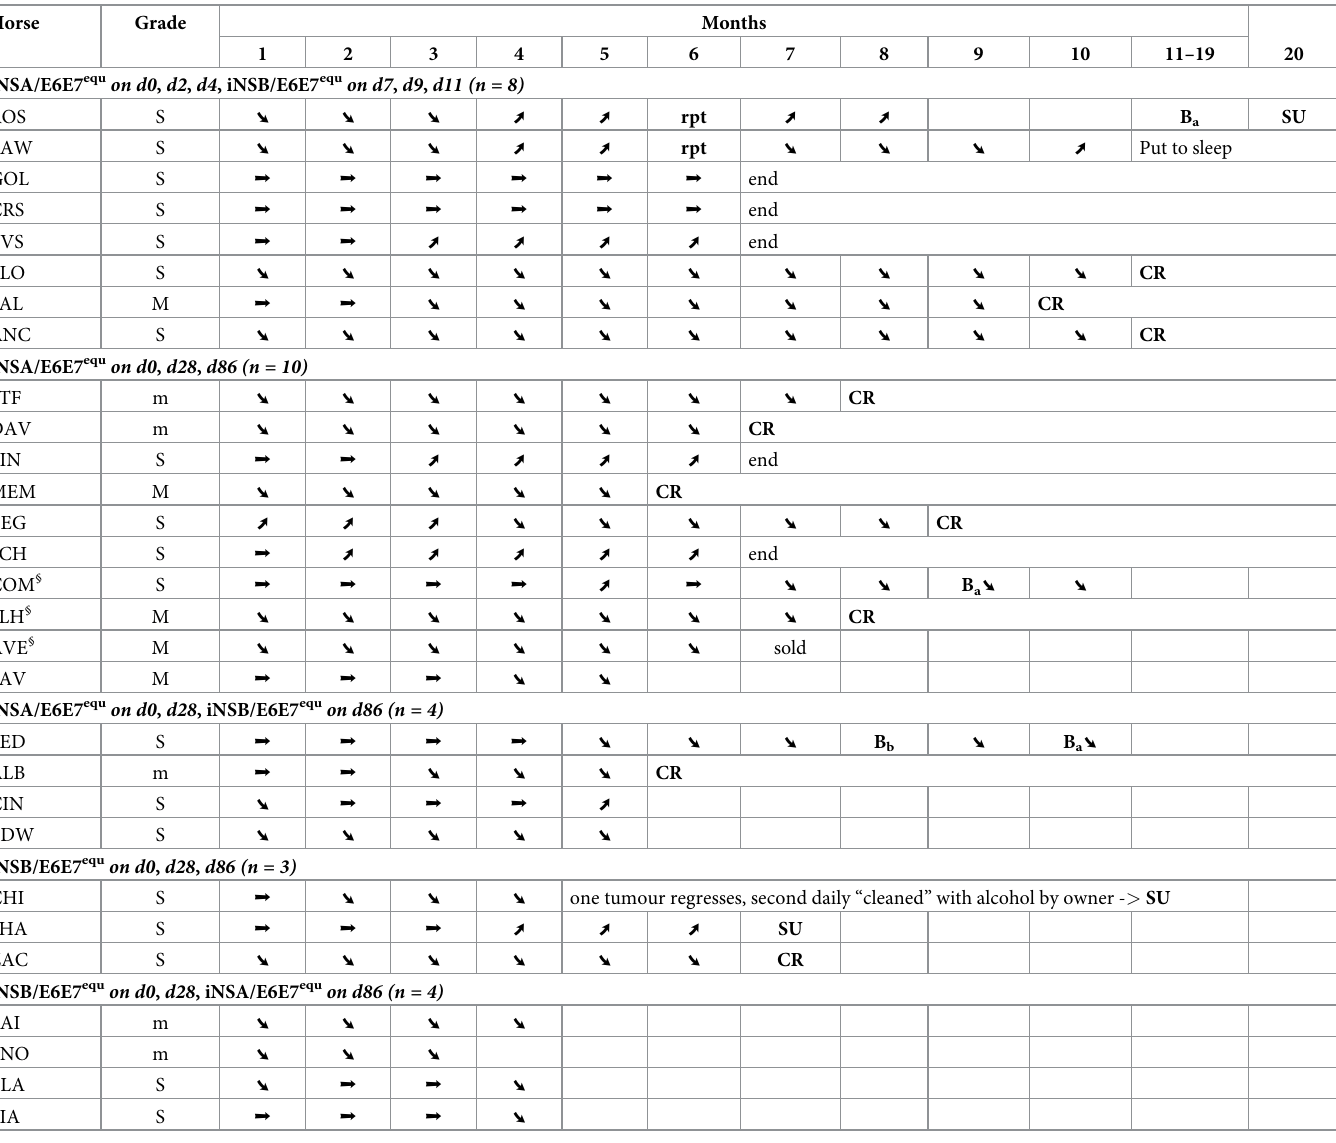
Table 3. Response to